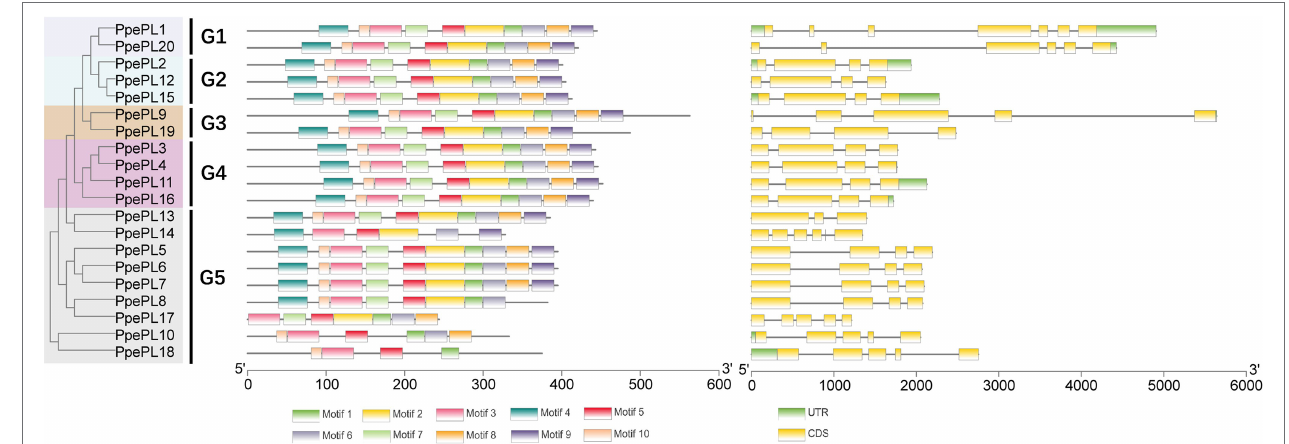
FIGURE 4 | Analysis of PpePL gene structures. The left part indicates the unroot phylogenetic tree of PpePL proteins. Different colors represent different groups. The middle part represents conserved motif analysis by MEME website. Up to 10 motifs were shown by different colors. The right part shown the exon–intron organization of PpePL genes. Yellow box and black line were exon and intron positions, respectively. Green box represents the 3 ′ -UTR in purple and 5 ′ -UTR. CDS, coding sequence; UTR, untranslational region.